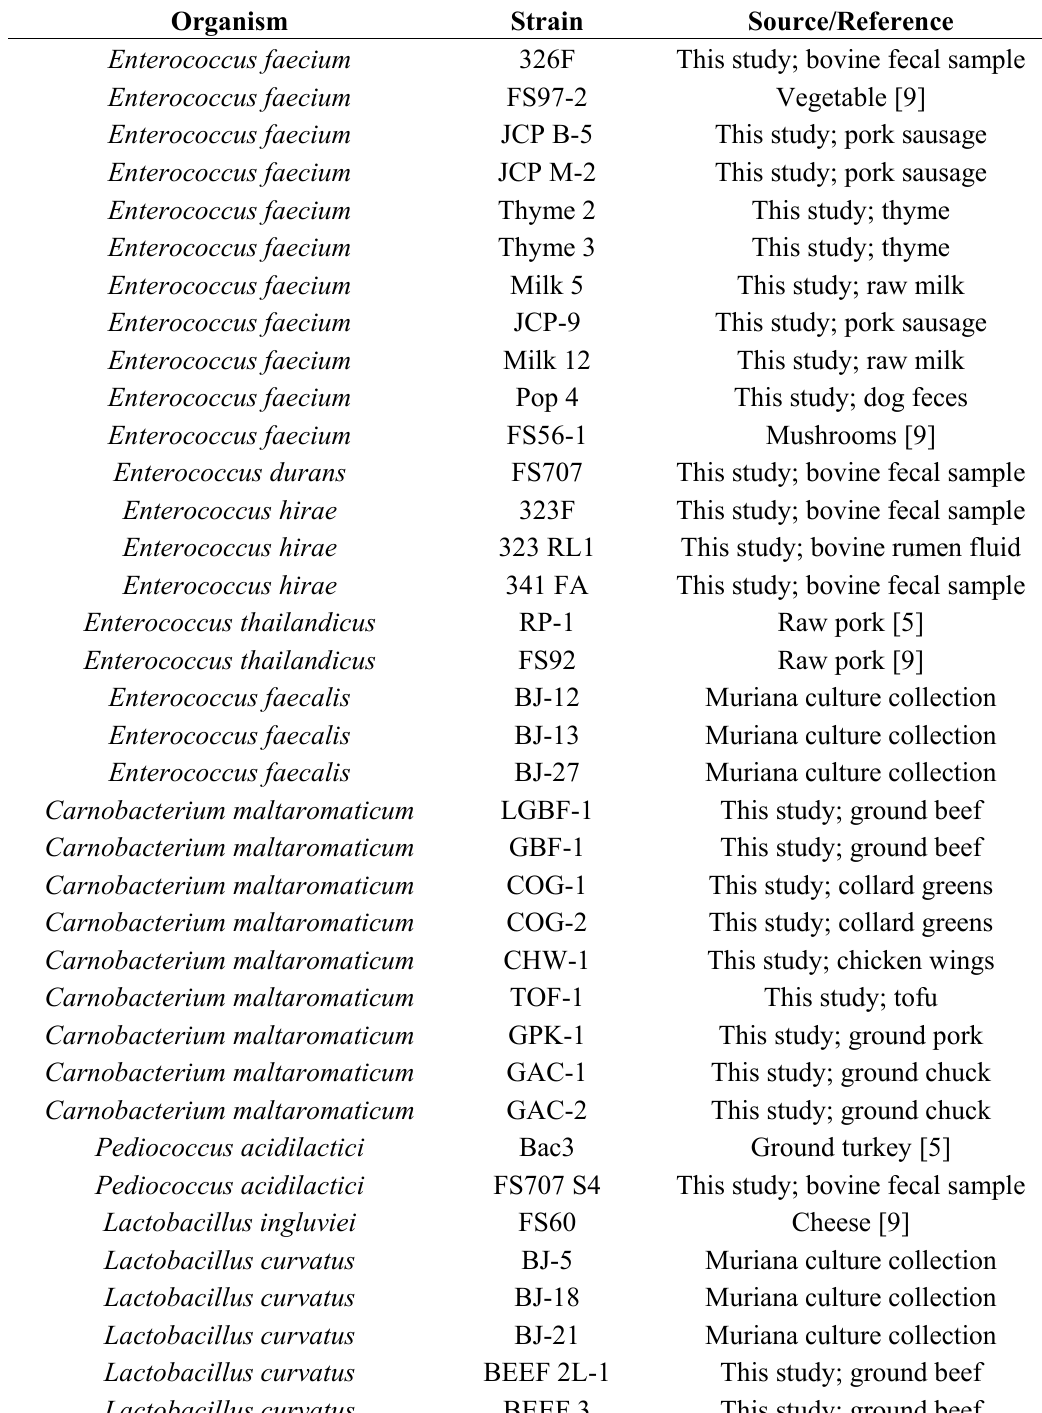
Table 1. Bacteriocin-producing strains isolated or used in this